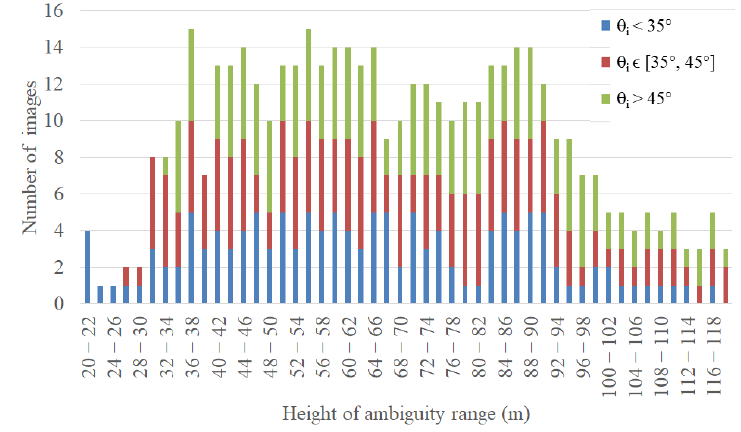
Figure 4. Overall distribution of the TanDEM-X input acquisitions used for training with respect to the considered h Amb and θ i intervals.